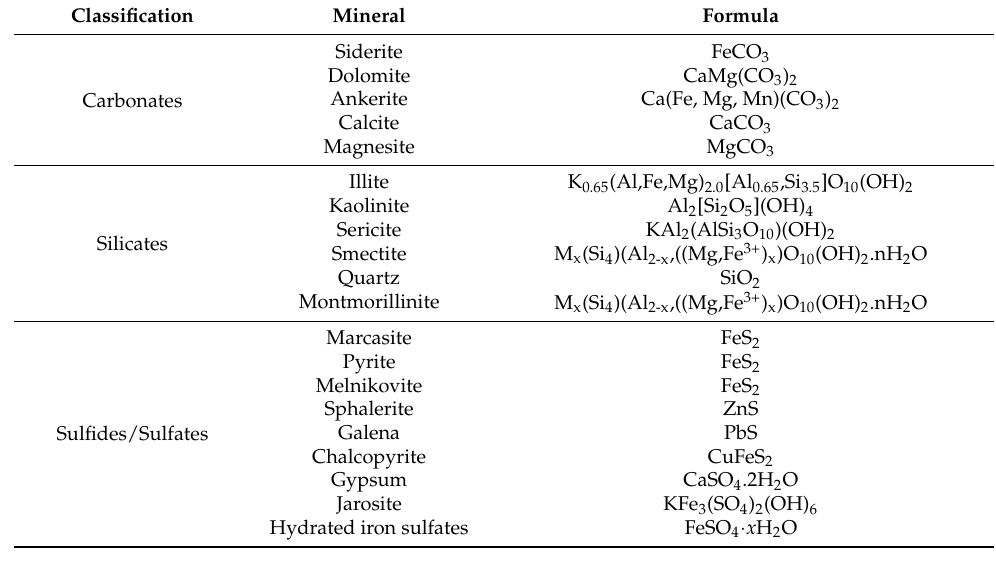
Table 3. Typical RCMD minerals [172,173].